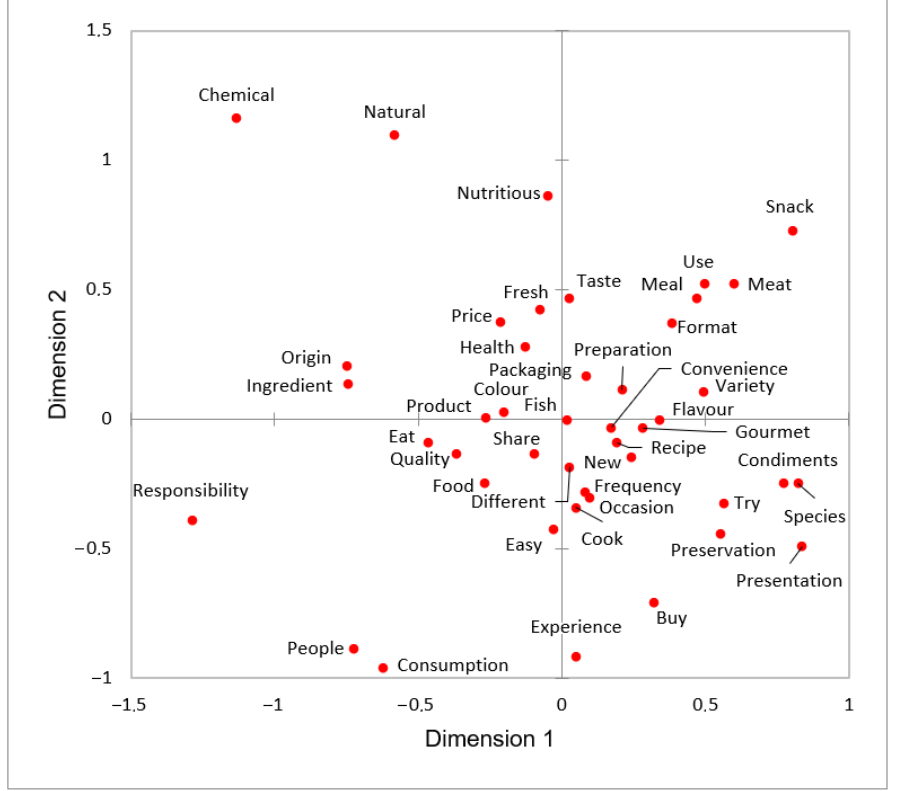
Figure 3. Multidimensional scaling of the 44 categories obtained using Alceste software, grouped by the first pseudo-triangulation process, and reduced by frequency of co-occurrence (Dimensions 1 and 2).